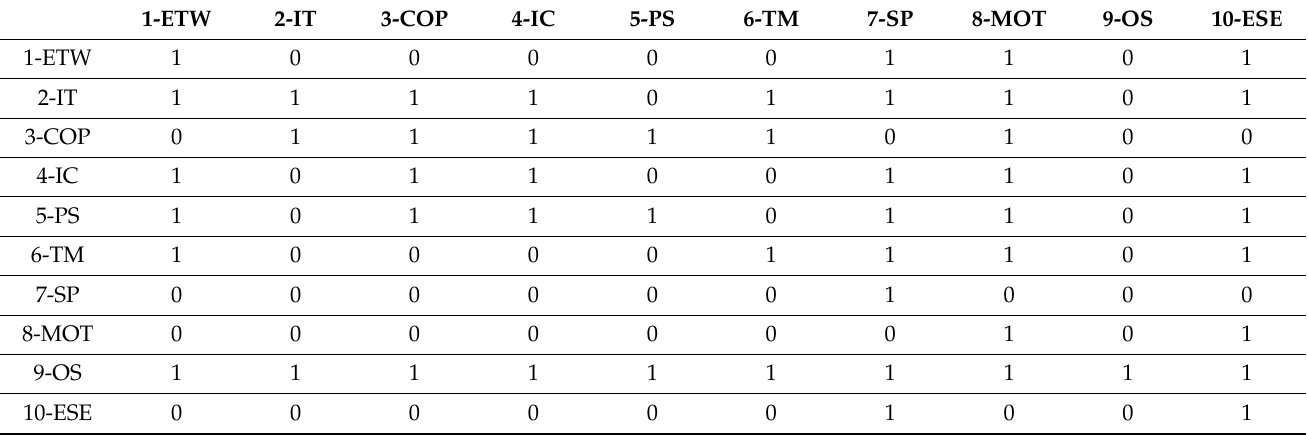
Table 2. Initial reachability matrix of SSIM.